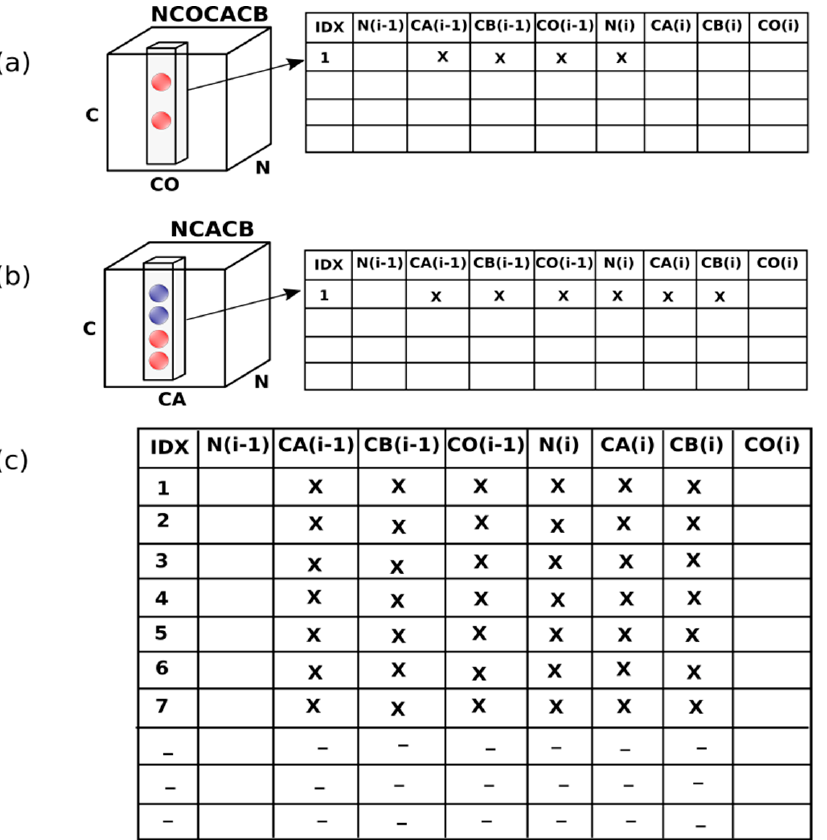
Figure 1. Spin system matrix assembly in ssPINE. ( a ) Peaks from the strip of the NCOCACB experiment containing the CA(i − 1) and CB(i − 1) resonances are inserted in the row of the table corresponding to the ith residue (IDX). Note that the peak is selected from the CO(i − 1) and N(i), in root information. ( b ) Similarly, peaks from the strip of the NCACB experiment containing the CA(i) and CB(i) resonances are inserted in the row of the table corresponding to the ith residue. N(i) and CA(i) in root information are used to select a peak from NCACB. ( c ) The process is repeated for all residues in the peptide sequence.